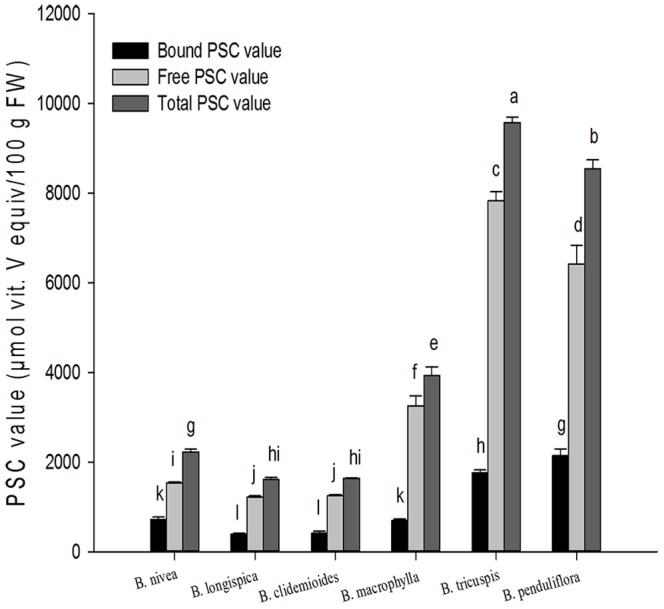
PSC values in six species of ramie leaves (mean ± SD, n = 3).Bars with no letters in common are significantly different (p<0.05).